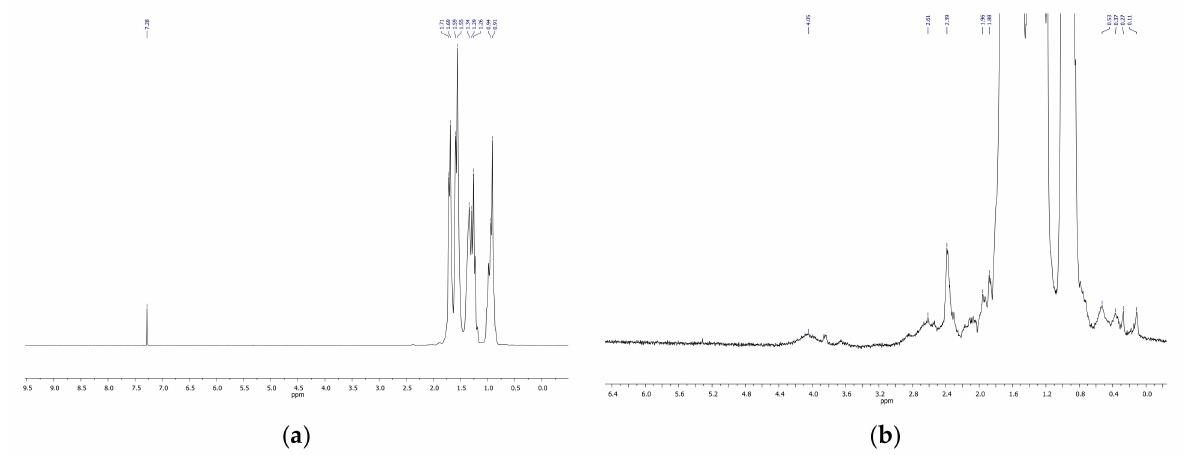
Figure 9. 1 H-NMR spectrum of the mixture of cis and trans-decalins after ozonation for 70 min in a wide range of chemical shifts ( a ) and in the narrow range of 0–6 ppm ( b